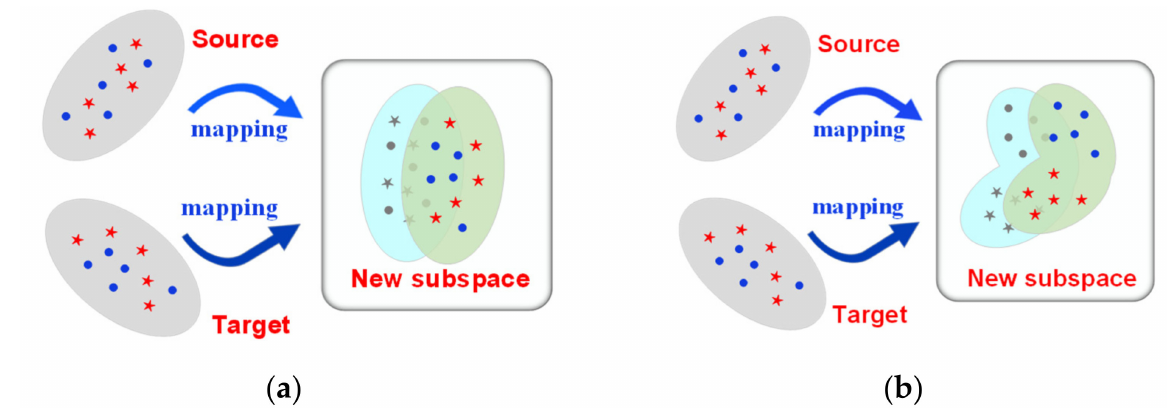
Figure 3. The distribution adaptation. ( a ) Purely for marginal distribution adaptation; ( b ) With the features being mapped into the new space, the inter-class maximal divisibility was achieved and the distribution difference between the source domain and target domain was